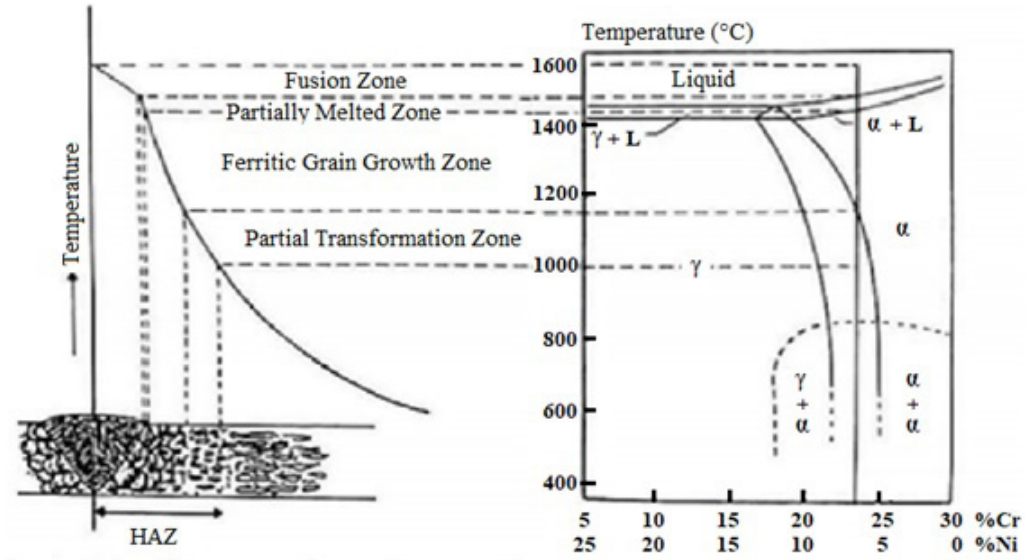
Figure 6. Microstructural changes in welded joint of SDSS 39